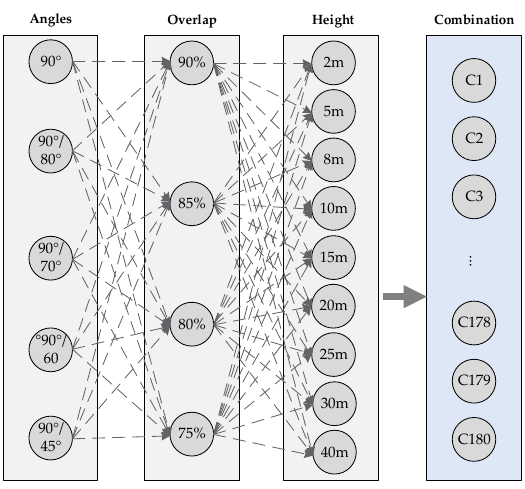
Figure 4. Combination of variables that influence the accuracy of the UAV—SfM–MVS model.